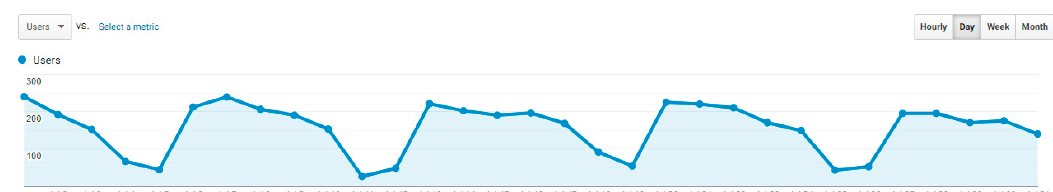
Figure 1. Fragment of the activity schedule.